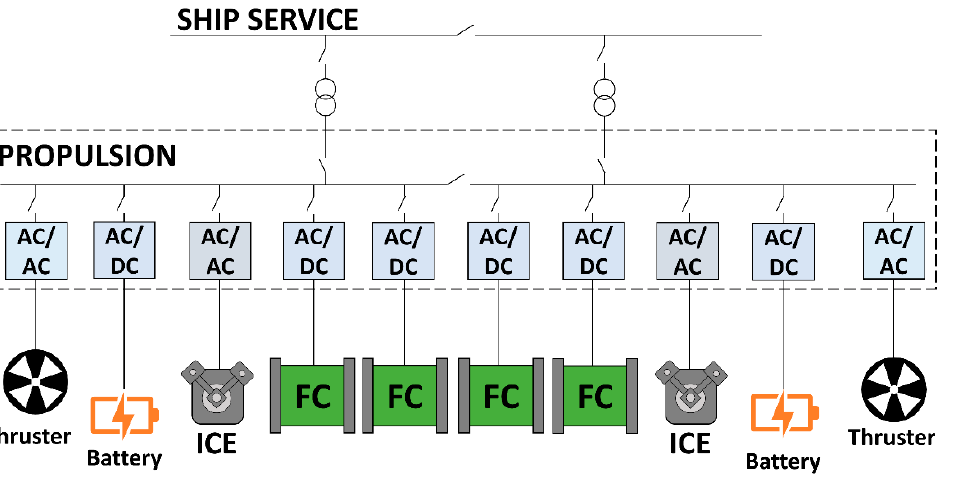
Figure 3. Propulsion and service system block diagram for a hybrid (fuel cells and batteries) system (adapted from [107]; abbreviations: AC: alternative current, DC: direct current, FC: fuel cell).